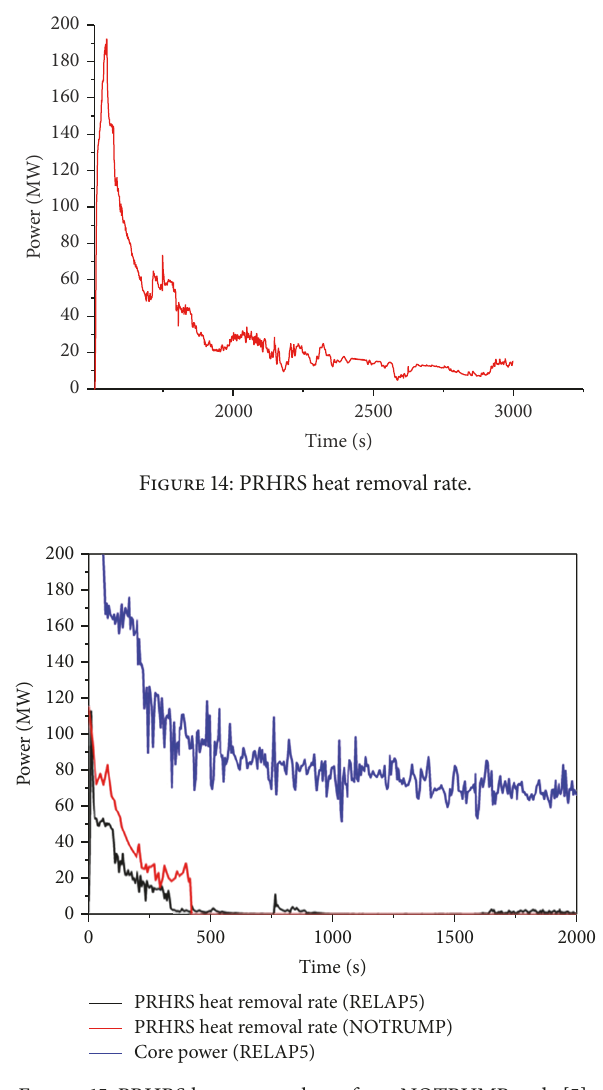
Figure 15: PRHRS heat removal rate from NOTRUMP code [5].